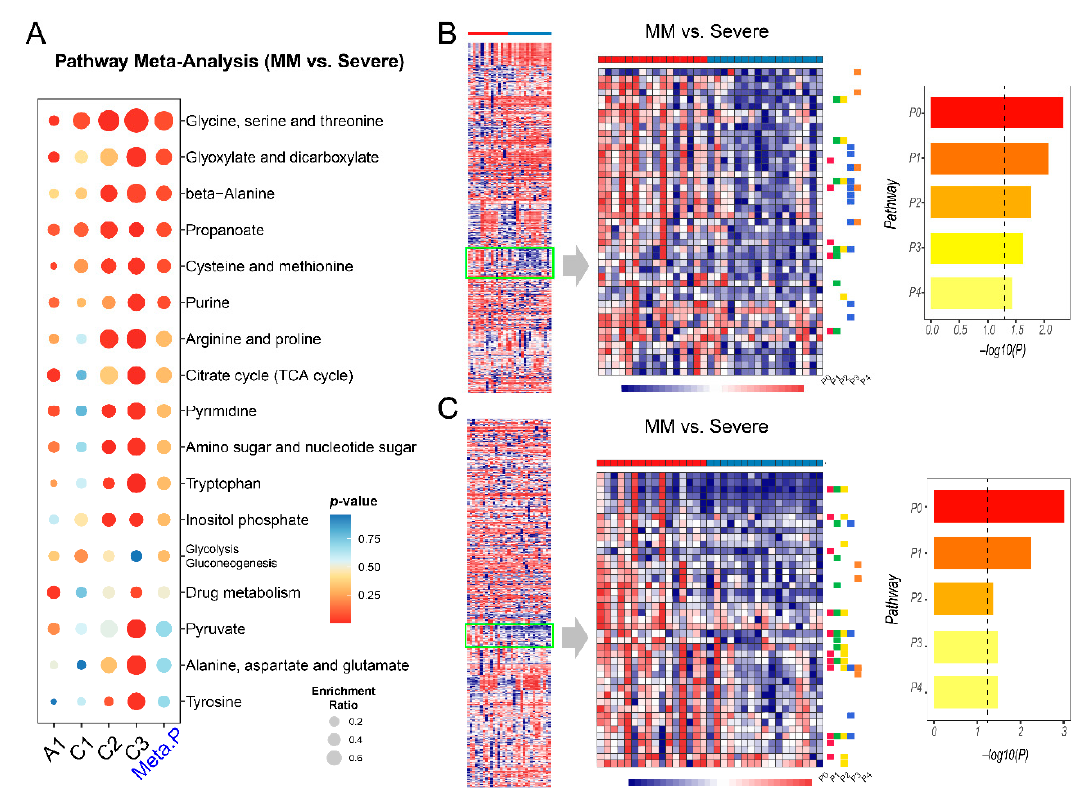
Figure 5. Metabolic pathway analysis and cluster heatmap analysis between mild-to-moderate (MM) and severe groups. ( A ) Summary of pathway analysis and meta-analysis result. ( B ) Enrichment analysis on a pattern of interest identified in dataset A1 (negative ion mode). P0: Caffeine metabolism; P1: Glyoxylate and dicarboxylate metabolism; P2: Citrate cycle (TCA cycle); P3: Purine metabolism; P4: Lysine degradation. The vertical dashed line in the bar plot is the threshold of p = 0.05. ( C ) Enrichment analysis on a pattern of interest in A1 (positive ion mode). P0: Glycine, serine and threonine